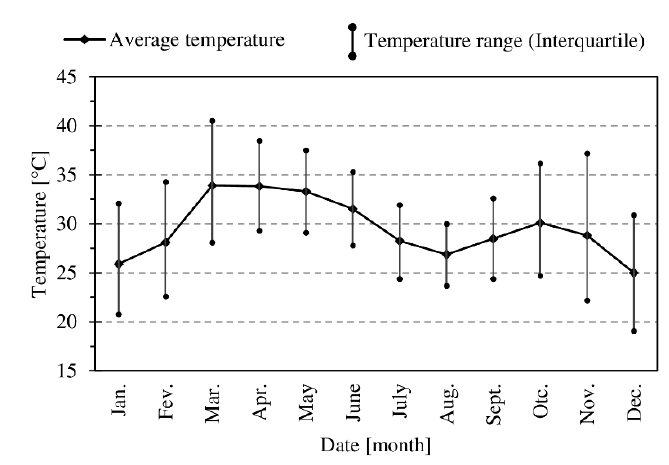
Figure 2. Evolution of air temperatures of Ouagadougou based on TMY2 data.